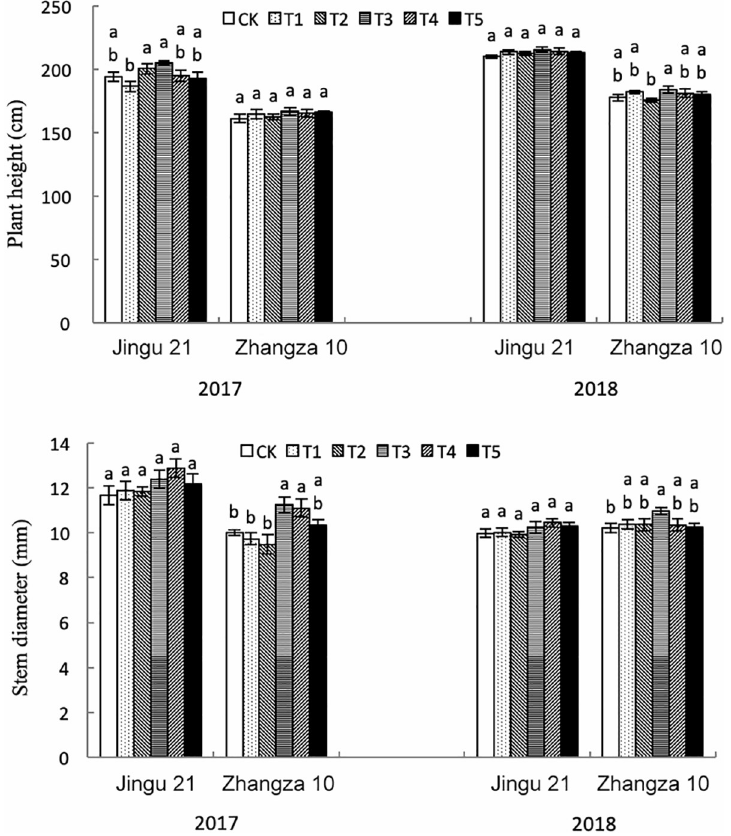
Fig 1. Effect of humic acid on plant height and stem diameter of foxtail millet in the years 2017 and 2018. X-axis represents different cultivars of foxtail millet; y-axis represents different plant traits. CK, T1, T2, T3, T4, and T5 represent different concentrations of HA (0 mg L -1 , 50 mg L -1 , 100 mg L -1 , 200 mg L -1 , 300 mg L -1 , and 400 mg L -1 ). Lowercase letters in the same column indicate significant differences at the 0.05 level.